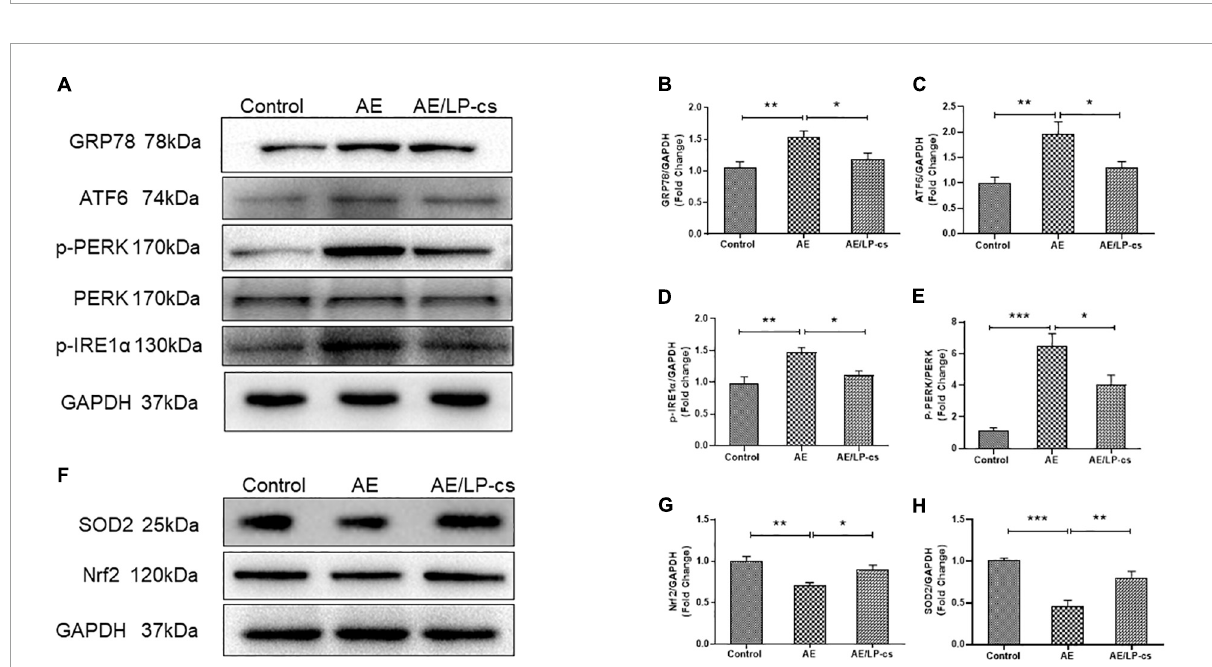
FIGURE5 Lactobacillus plantarum culture supernatants alleviates alcohol-induced elevated ER stress and oxidative stress in the hippocampus. (A–E) Western blot and quantitative analysis of the ER stress-related protein expression in the hippocampus from the mice. (F–H) Western blot and quantitative analysis of the Nrf2 and SOD2 expressions in the hippocampus from the mice. Control vs. AE and AE vs. AE/LP-cs, * p < 0.05, ** p < 0.01, *** p < 0.001, n =